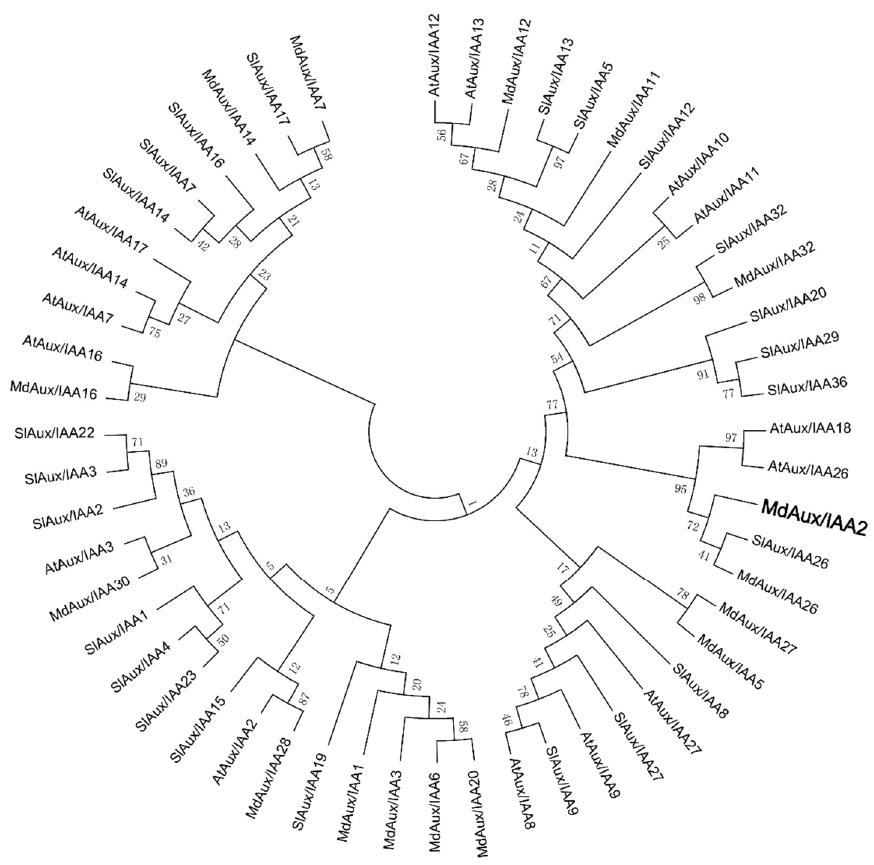
Figure 4. Phylogenetic tree analysis of MdAux/IAA2.The amino acid sequences of the Aux/IAA family in Arabidopsis thaliana , tomato, and apple were downloaded, and phylogenetic trees were constructed using the neighbor-joining method of MEGA7 software. Bold part is MdAux/IAA2.